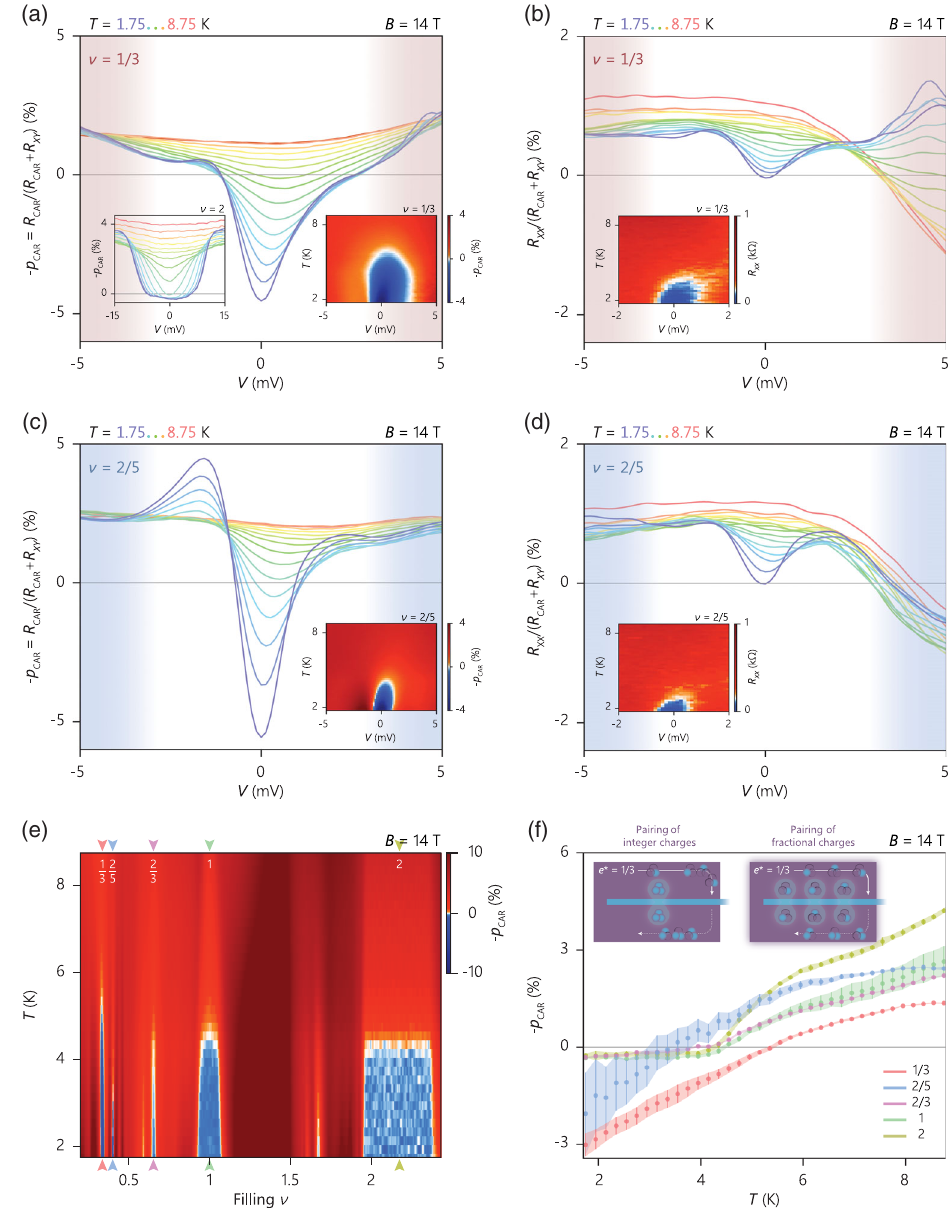
FIG. 5. Transport spectroscopy and temperature dependence. (a) p at ν ¼ 1 = 3 as a function of the incoming edge mode potential V CAR (excitation) for different temperatures T . Crossed Andreev reflection is limited to below j e V j ∼ 1 meV and T < 6 K. Increasing excitation and T suppress CAR. Left-hand inset of (a) shows p at ν ¼ 2 with a V and T dependence similar to that at ν ¼ 1 = 3 apart CAR from a larger V range and a smaller p . Right-hand inset of (a) shows the p corresponding to (a). (b) R corresponding to (a), XX CAR CAR þ R divided by the incoming edge mode potential R , allowing a direct comparison to p . Increasing excitation and T result in XY CAR CAR bulk conductance which suppresses CAR. Inset of (b) shows R corresponding to the right-hand inset of (a). (c),(d) Same as (a) and XX < 0 (b) but for ν ¼ 2 = 5 , which shows a V and T dependence similar to that for ν ¼ 1 = 3 . (e) p as a function of ν for varying T . R CAR CAR below ∼ 5 K for all well-developed fillings (highlighted with arrows). (f) Vertical cuts from (e). At ν ¼ 2 = 3 , 1, and 2. p saturates CAR below ∼ 4 K with decreasing T , whereas at ν ¼ 1 = 3 and 2 = 5 continues to increase in amplitude without saturating. The shades are the uncertainty in the measurement while sweeping the gate voltage. The uncertainty is larger for fillings represented by fewer data points. Insets of (f) illustrate two different mechanisms of charge transport to the superconductor. Left-hand schematic illustrates bunching of fractional charges of e (cid:2) ¼ 1 = 3 to form integer charges of e that pair. This mechanism converts three incoming e (cid:2) to an outgoing − e , an integer-charged hole, adding 2 e to the superconductor. Right-hand schematic illustrates the pairing of fractional charges, a mechanism that converts e (cid:2) to − e (cid:2) , adding 2 e= 3 to a fractional topological superconductor. For pairing of integer charges, p vanishes at T ¼ 0 . CAR In contrast, p monotonically increases in amplitude with decreasing T when fractional charges CAR